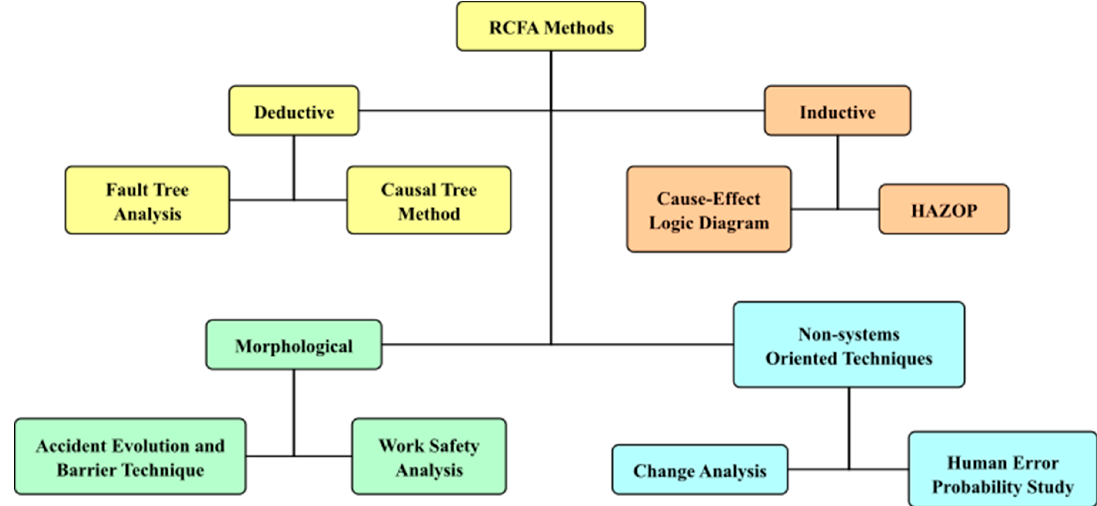
Figure 2. Root Cause Failure Analysis (RCFA) Methods. “Source [16], own elaboration.”.